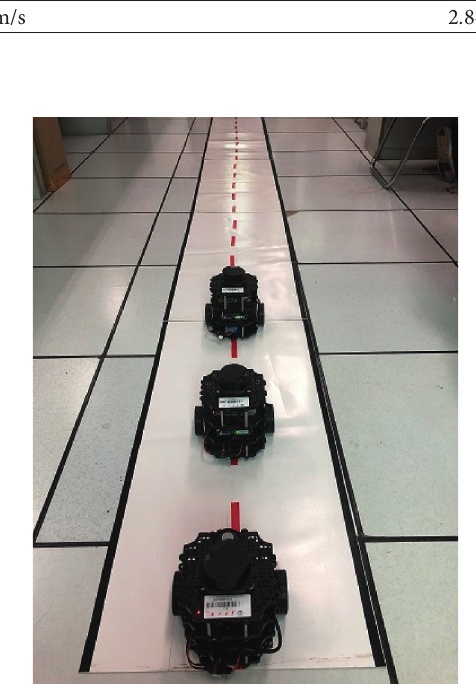
Figure 8: TurtleBot3 platoon in the experiment.